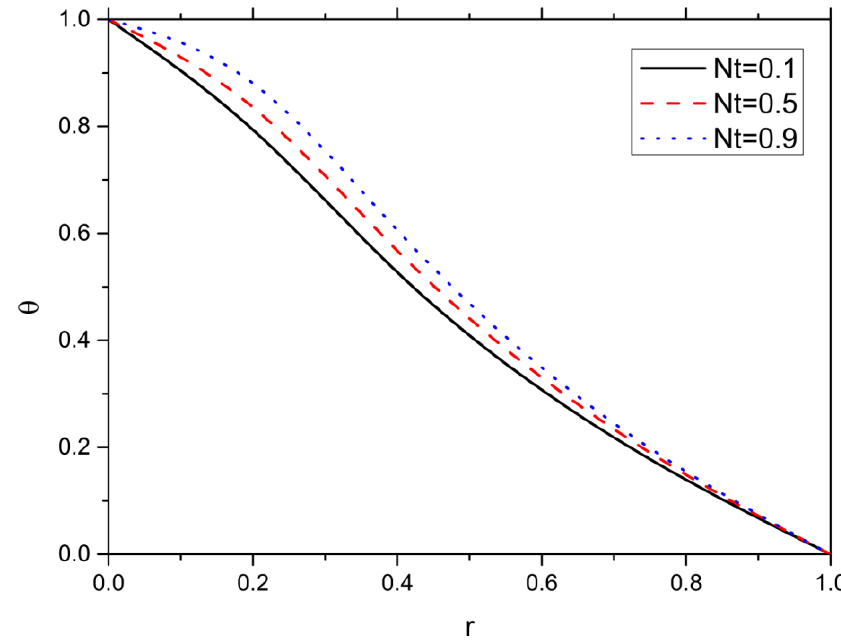
N = 0.4,  = 0.2,  =0.1, z = b